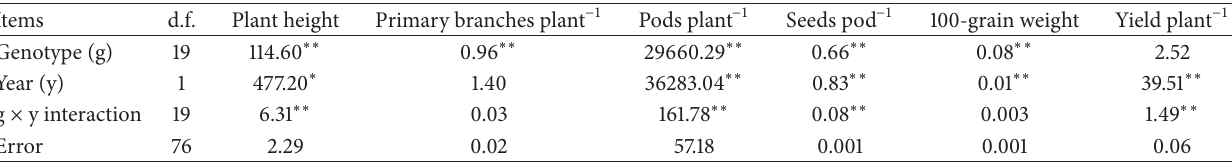
Table 1: Analysis of variance for six yield contributing characters in 20 lentil genotypes and their interaction in two growing seasons (2010-11 and 2011-12).